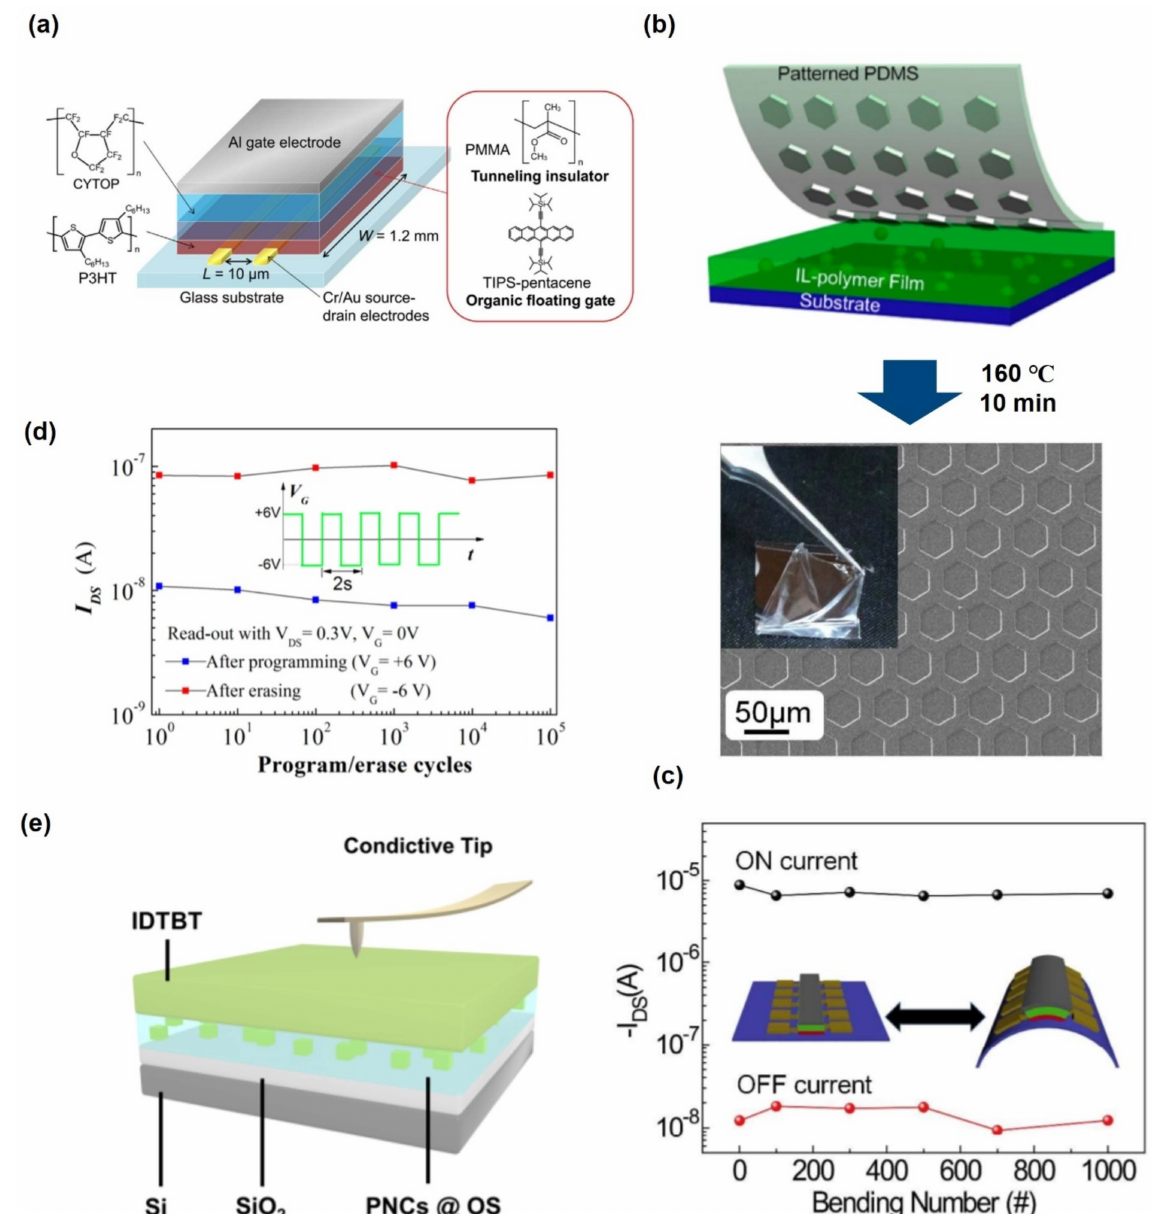
Figure 1. Classification of the floating-gate according to material: ( a ) metal electrode and using an organic semiconductor (adapted from [32] with permission from Elsevier.), ( b ) schematic and SEM image of the blended polymer (adapted from [33] with permission Figure 33. with permission from the American Chemical Society), ( c ) on, off current at using blended polymer (with permission from the American Chemical Society), ( d ) on/off current at the metal oxide nanoparticle (adapted from [34] with permission from the American Chemical Society), and ( e ) the schematic of floating-gate memory using nanocrystal (adapted from [35] with permission from the American Chemical